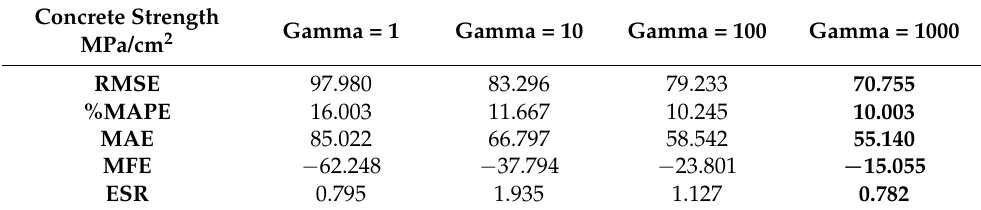
Table 6. SVMs training errors with two input results with fixed sigma = 32.